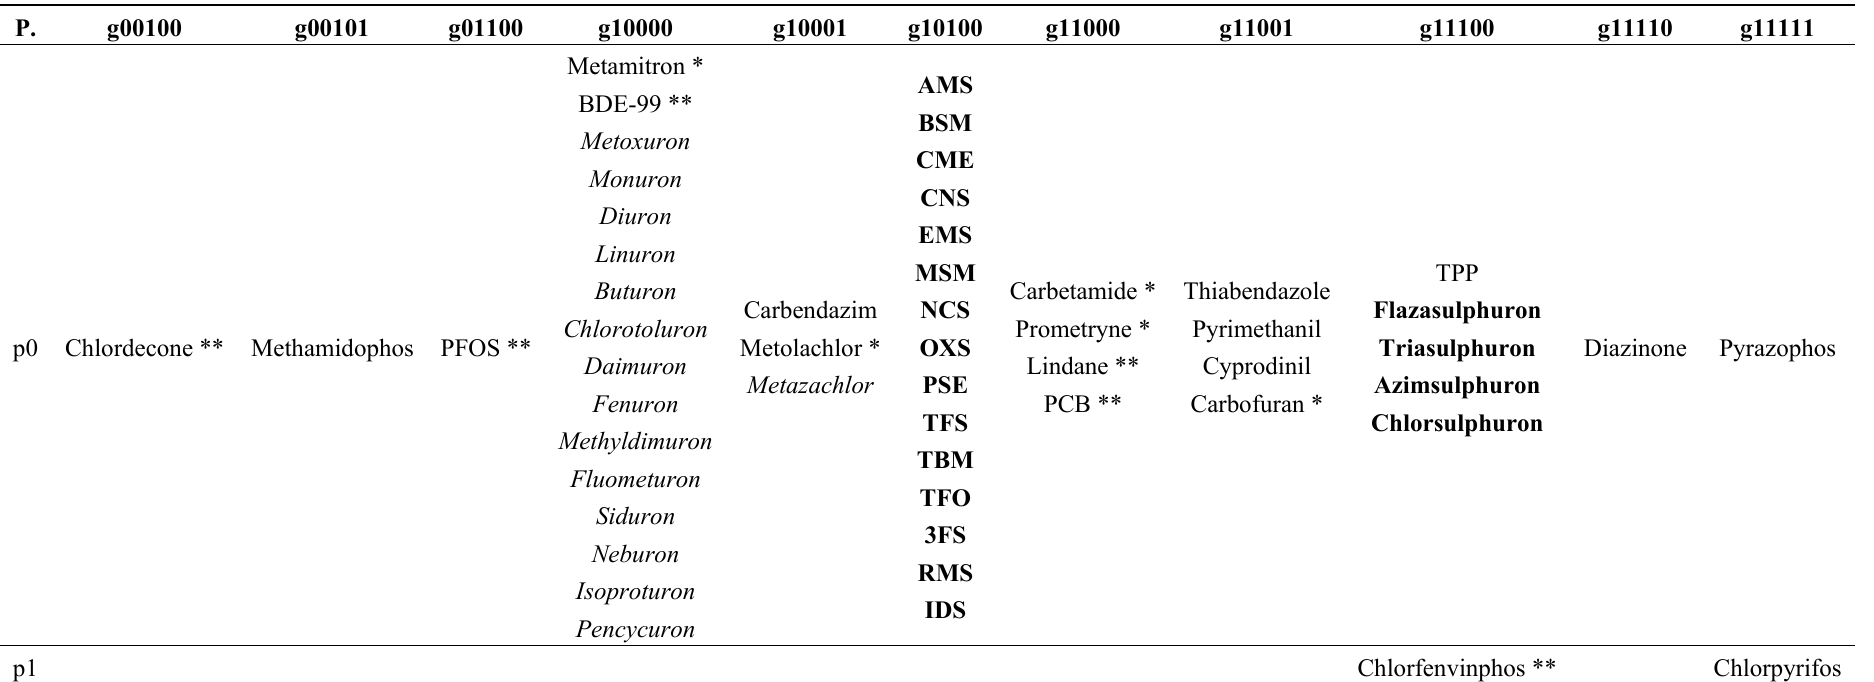
Table 6. Table of periodic properties for pesticides, persistent organic pollutants, phenylureas and sulphonylureas.